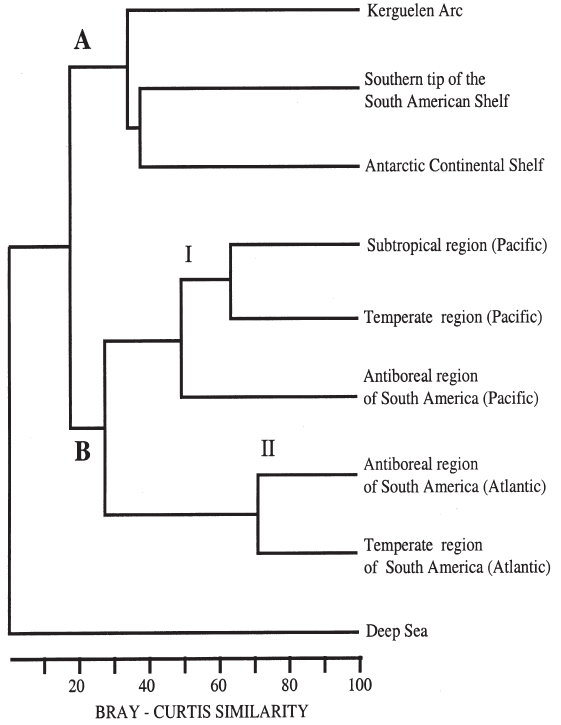
F IG . 3. – Dendrogram of the cluster analysis based on presence / absence data. The figure demonstrates a high degree of dissimilari- ty between group A and B, and suggests that the decapod species from the islands of the Kerguelen Arc and the southern tip of South America should be included within the Antarctic fauna. The dis- similarity between group I and II separates the Atlantic and Pacific Provinces from the antiboreal South American